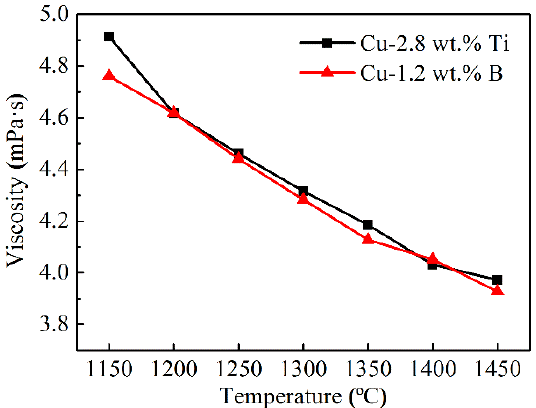
Figure 5. Viscosity–temperature curves of the molten Cu-B and Cu-Ti master alloys.